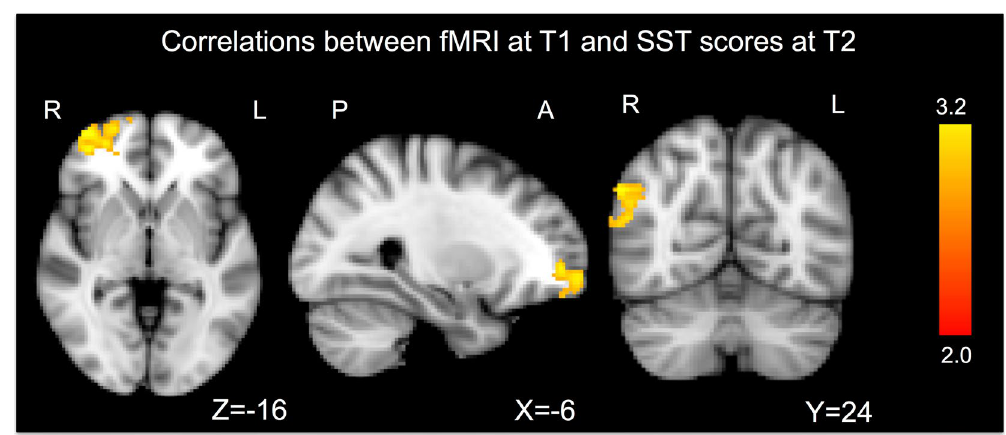
Figure 3. Post-hoc correlation analyses between the GLM activations at T1 and the clinical Simple Shoulder Test scores at T2. Higher activation in in the right-frontal pole and right occipital cortex correlates with SST scores at follow-up. Results show brain areas surviving TFCE correction. P values < 0.05 were considered as significant. No significant correlations were found for the other test